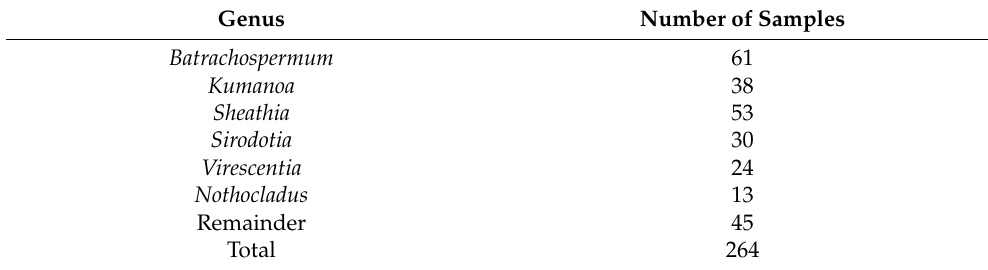
Table 2. The number of samples per genus in the database compiled in this